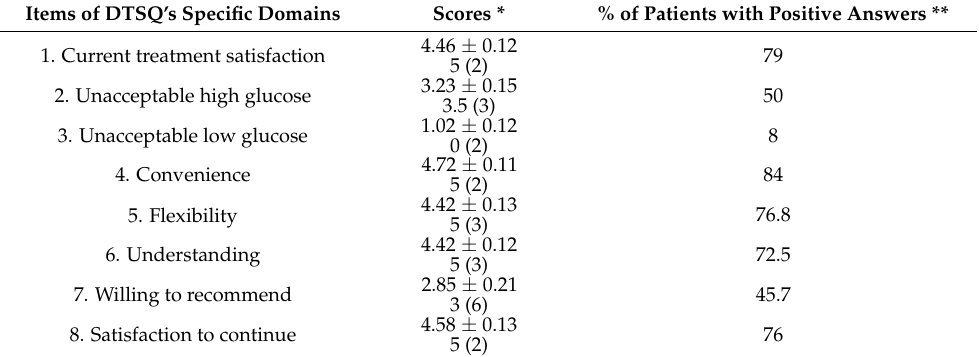
Table 2. Diabetes Treatment Satisfaction Questionnaire results—as assessed by patients. Items of DTSQ’s Specific